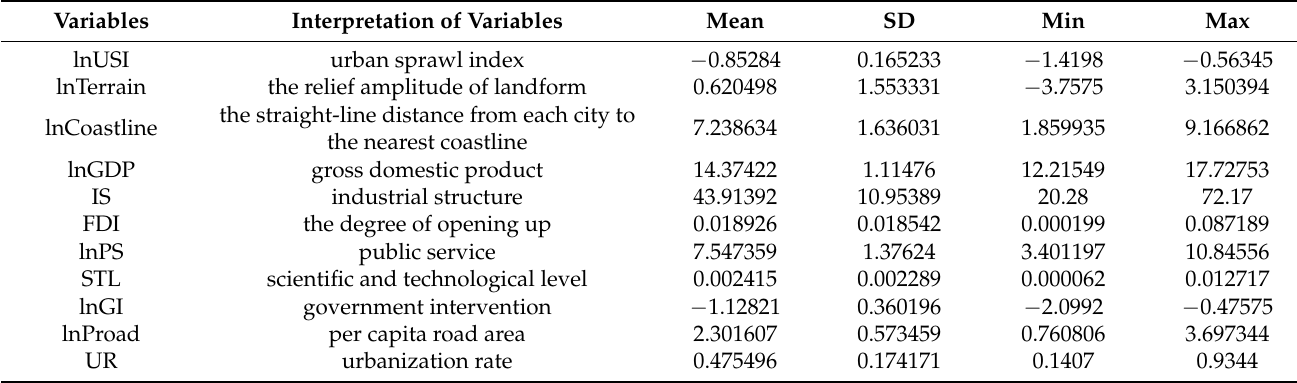
Table 1. Summary statistics of the